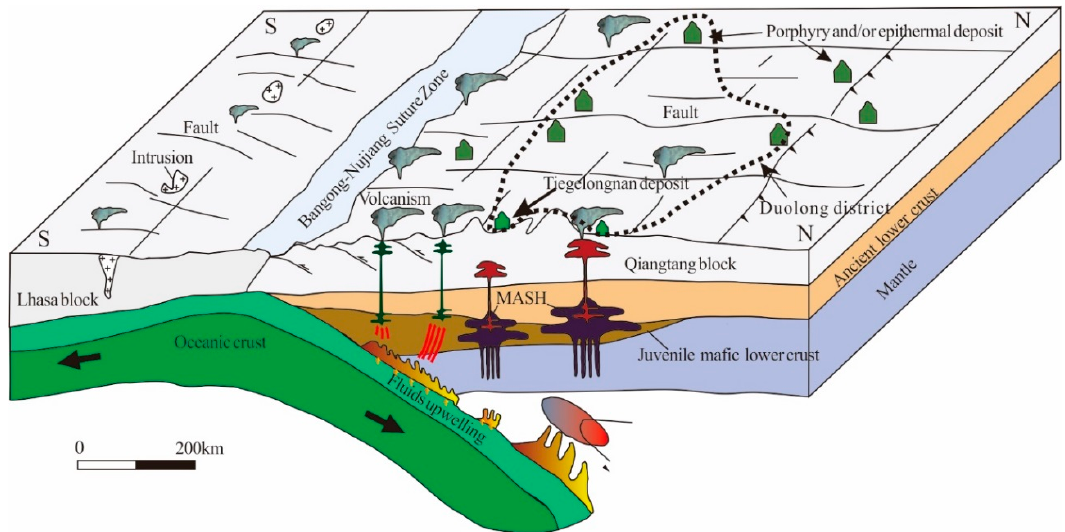
Figure 9. Tectonic setting model for the formation of the Duolong deposit, Tibet.